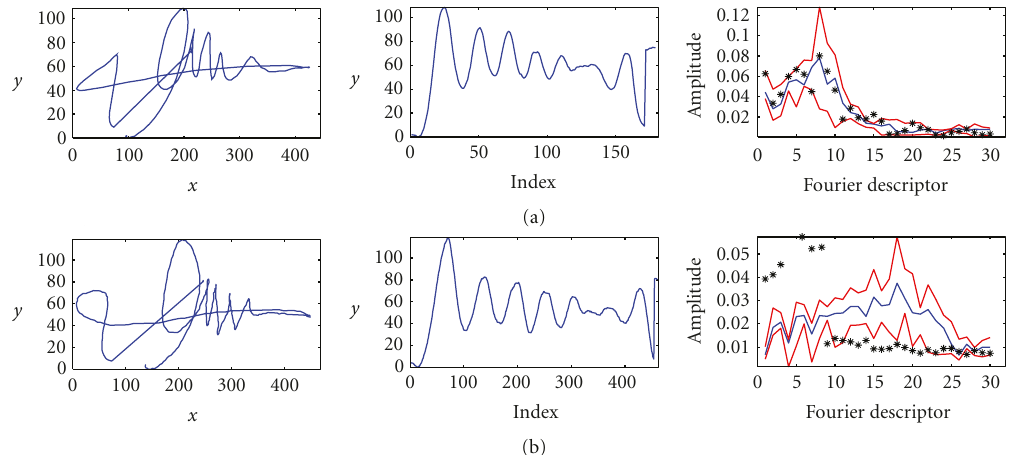
Figure 2: A verification case is shown for illustration, using only the y -profile. From left to right: (a) Genuine signature, its y -profile and its Fourier Descriptors. (b) Forgery signature, its y -profile and its Fourier Descriptors. The Fourier Descriptors of genuine and forgery signatures (shown as dots) are overlaid on top of the envelope showing the min and max values of the reference signatures’ descriptors, while the line in the middle denotes the mean reference